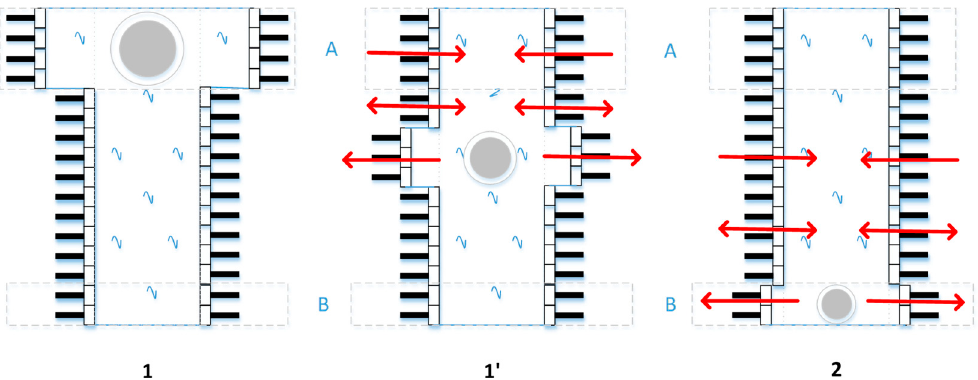
Figure 3. Fall of the balloon and corresponding movements of the side pistons. 1: start of the compression. 1 ′ : during the compression. 2: end of compression. A and B represent sub-systems at the top and bottom of the column respectively. Red arrows represent the movement of the side pistons.